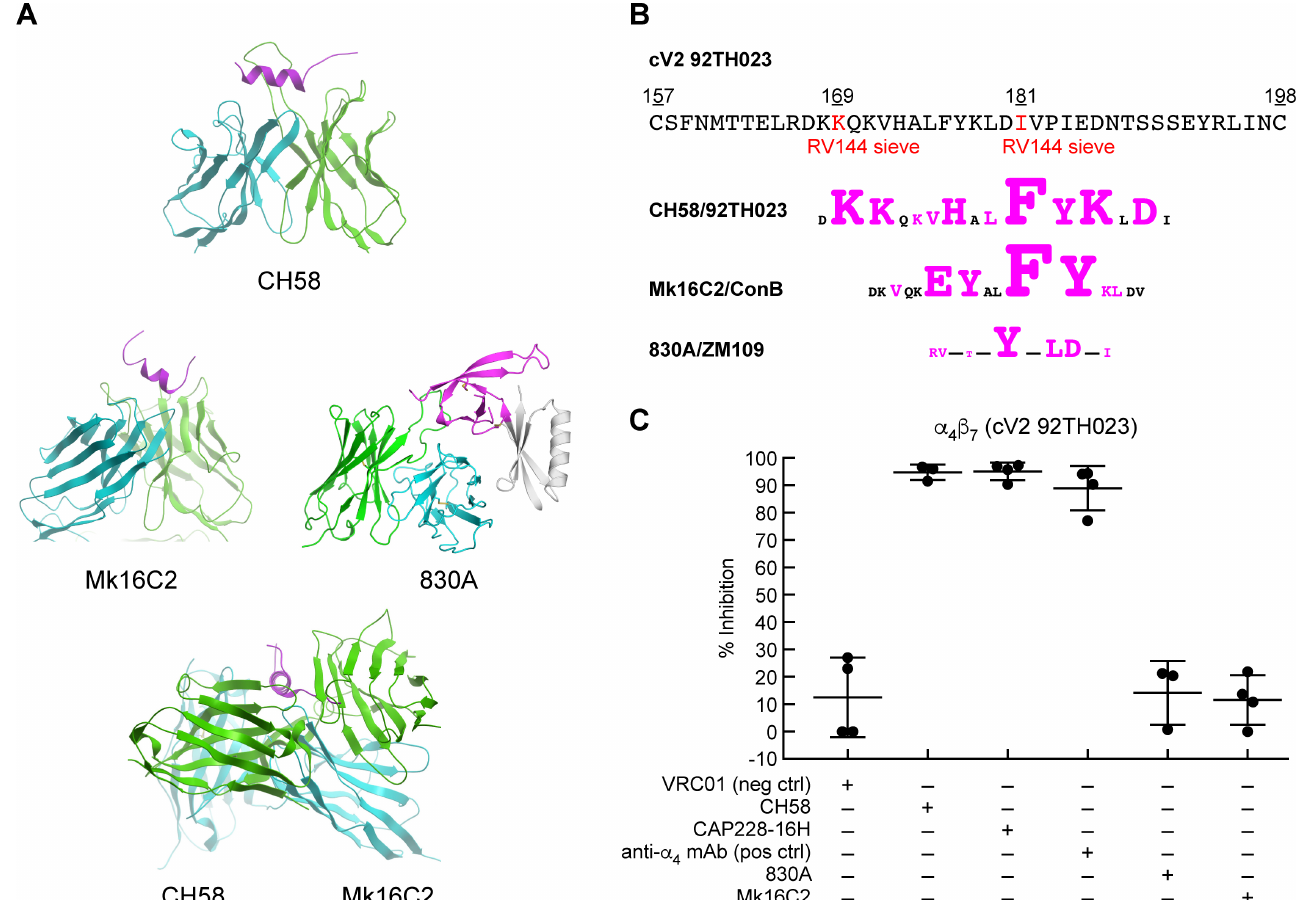
Fig 3. The structures of V2 mAbs in complex with peptides, and V2 mAb inhibition of α 4 β 7 adhesion. A) Crystal structure of three V2 domain mAbs, CH58 (PDB ID: 4HPO), Mk16C2 (PDB ID: 6CEZ), and 830A (PDB ID: 4YWG) in complex with V2 peptides, and a superimposition of CH58 and Mk16C2 binding to opposite sides of the same helical region of a V2 peptide. Only the Fv regions are shown with the heavy chain, light chain, and the V2 epitope colored cyan, green, and magenta, respectively. B) Amino acid sequence of the V2 domain of 92TH023. Sieve residues identified in the RV144 vaccine study are highlighted in red, along with schematics of the epitopes of CH58, Mk16C2 and 830A aligned below (with the corresponding HIV isolate listed). Residues in contact with each mAb are highlighted in magenta and the size of each amino acid is proportional to the contact surface area. C) Adhesion of RPMI8866 cells to cV2 92TH023 in the absence or presence of V2 mAbs: CH58, CAP228-16H, 830A, and Mk16C2. The mAb VRC01 is included as a nonspecific mAb control, and the anti- α 4 mAb 2B4 is employed as a positive control. Adhesion was determined at OD 590nm and listed as % inhibition in three or more independent experiments relative to cV2 92TH023 in the absence of any inhibitor (y-axis). Error bars indicate SD.